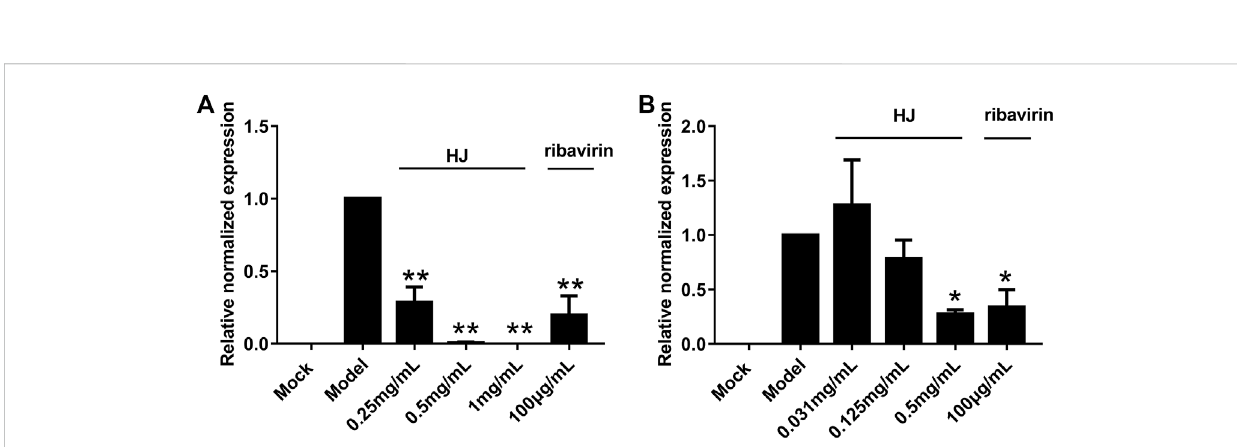
FIGURE 2 The PEDV N gene in infected Vero (A) or IPI-FX cells (B) was examined with real-time PCR using speci fi c primers. Cells were treated with HJ throughout the experiment. The expression level of N mRNA was calculated in relation to the expression level of GAPDH at 24 hpi. Results are representativeofthreeindependentexperiments. Dataare representedas mean± SD, n = 3.*,and p < 0.05;**,and p < 0.01wereconsideredstatistically signi fi cant compared with the model